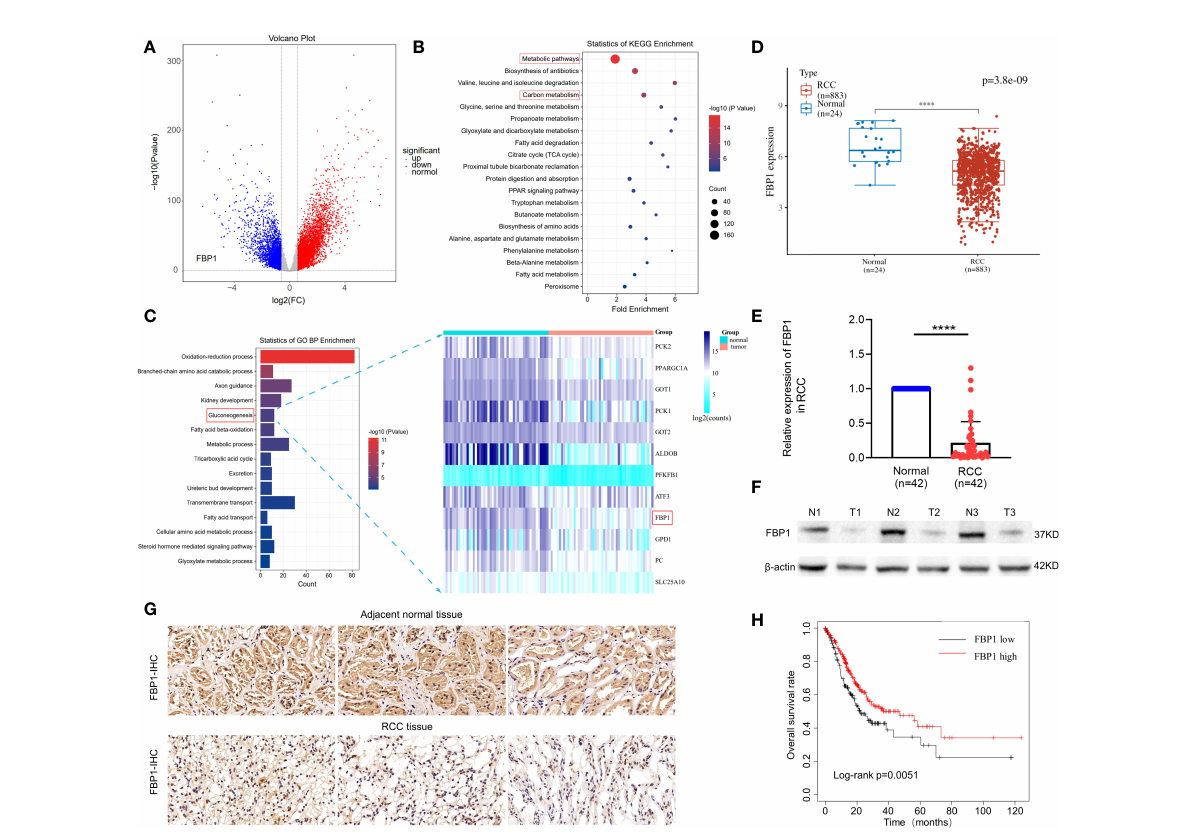
FIGURE 1 FBP1 is reduced in RCC and related to poor survival outcome. (A) Volcano Plot of differentially expressed mRNAs associated with glucose metabolism of Warburg effect in RCC and adjacent normal tissues. Blue represents downregulated genes, and red represents upregulated genes. p < 0.05. (B, C) KEGG pathway and gene oncology (GO) pro fi ling for the downregulated genes in RCC. (D) The mRNA expression levels of FBP1 in RCC and adjacent normal renal tissues from TCGA database by bioinformatic analysis. (E) The mRNA expression levels of FBP1 in RCC and adjacent normal renal tissues detected by qPCR. (F) The protein level of FBP1 in 3 randomly selected paired RCC and adjacent normal renal tissues by western blot. b-actin was used as input control. (G) Representative pictures of immunohistochemical (IHC) staining of 3 randomly selected paired RCC tissue and adjacent normal renal tissues. (H) Kaplan – Meier plots of overall survival in RCC patients with low expression of FBP1 (n=166) compared to high expression of FBP1 (n=178) strati fi ed by the expression levels of FBP1 . The cutoff was con fi rmed as the threshold with the best performance. Log-rank test p value is shown. Results are shown as mean ± S.D., ****p <